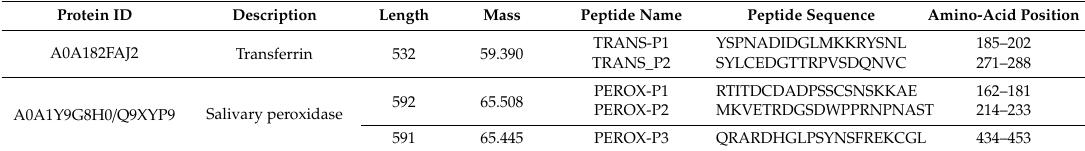
Table 2. List and characteristics of the immunogenic